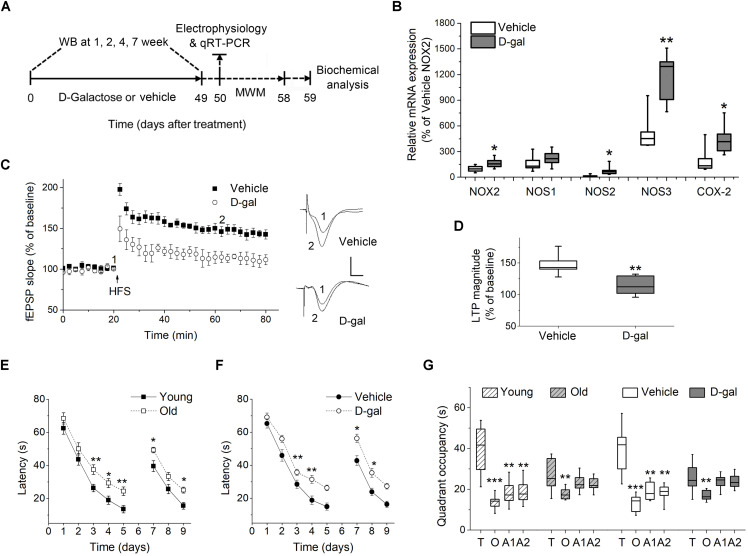
Chronic D-galactose (D-gal) treatment increased the mRNA level of several ROS-producing enzymes and induced memory deficits in rats. (A) Experimental setup used for assessing the behavioral and cellular responses to chronic D-gal administration. MWM, Morris water maze; WB, western blot. (B) A box graph showed the quantification of mRNA of interest by qRT-PCR in freshly isolated hippocampal CA1 neurons from rats received a 7-week vehicle or D-gal treatment, including NADPH oxidase isoform NOX2, neuronal nitric oxide synthase (NOS1), inducible nitric oxide synthase (NOS2), endothelial nitric oxide synthase (NOS3), and cyclooxygenase-2 (COX-2). Results were from six independent rats with triple wells. Data were normalized to the NOX2 mRNA level in control animals. (C) Time course of hippocampal long term potentiation (LTP) in the CA1 region after high-frequency stimulation of Schaffer collateral (HFS, arrow). Right, Representative fEPSP traces before (1) and 40 min after HFS (2) in vehicle and D-gal-treated animals. (D) Quantification of fEPSP slope change reveals a D-gal-induced occlusion of LTP (n = 5) when compared to the control (n = 6). The quantification was made by averaging normalized fEPSPs slope from 40 to 45 min after HFS. Calibration: 5 ms, 0.5 mV. *P < 0.05, **P < 0.01, compared with the vehicle group as determined by Student’s t-test in (B,D). (E) Acquisition and reversal phases of the MWM in rats aged 3 months (young) and 18 months (old). (F) Acquisition and reversal phases of the MWM in vehicle- and D-gal-treated rats. (G) Probe trial phase of the MWM tested at day 6. To show quadrant preferences, the time in the target quadrant was compared to the time in the rest three quadrants in each animal group (T, target quadrant; O, opposite quadrant; A1, adjacent 1 quadrant; A2, adjacent 2 quadrant). Young, n = 11; Old, n = 10; Vehicle, n = 8; D-gal, n = 13 rats. Statistical significance was calculated using two-way repeated measures ANOVA in (E,F) and one-way ANOVA in (G), followed by Bonferroni’s t-test. *P < 0.05, **P < 0.01, ***P < 0.001.